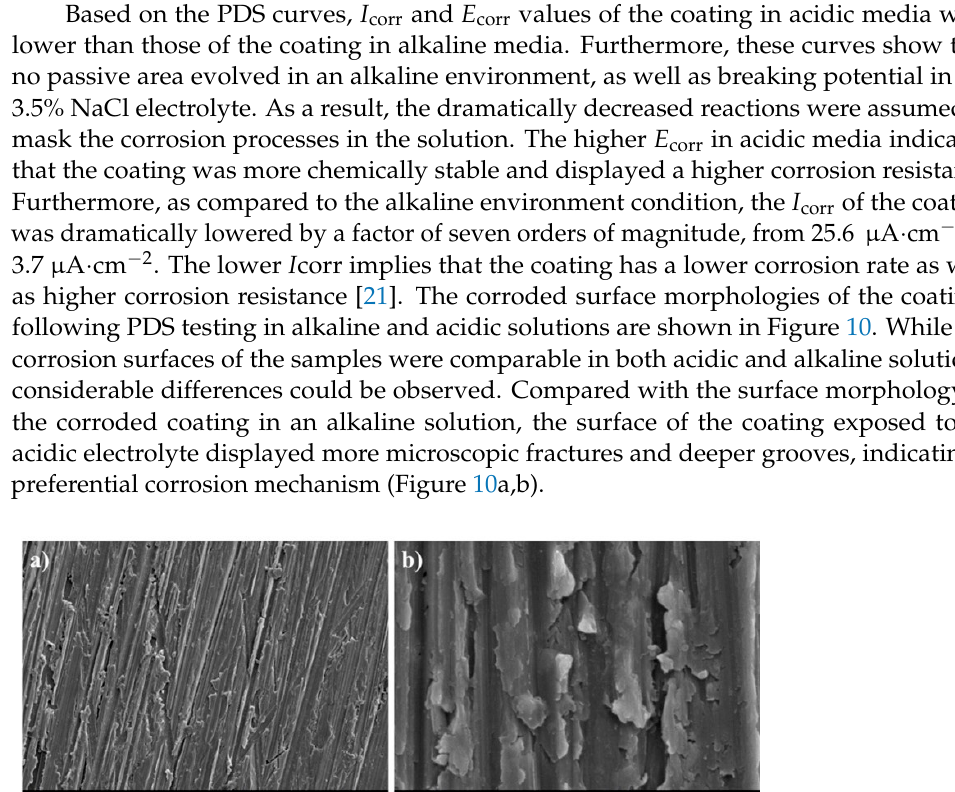
Figure 10. SEM images of the coating surfaces after corrosion tests ( a,b ) in Na 2 SO 4 and ( c,d ) in NaCl solutions. Table 2. Some important corrosion parameters calculated from PDS curves.